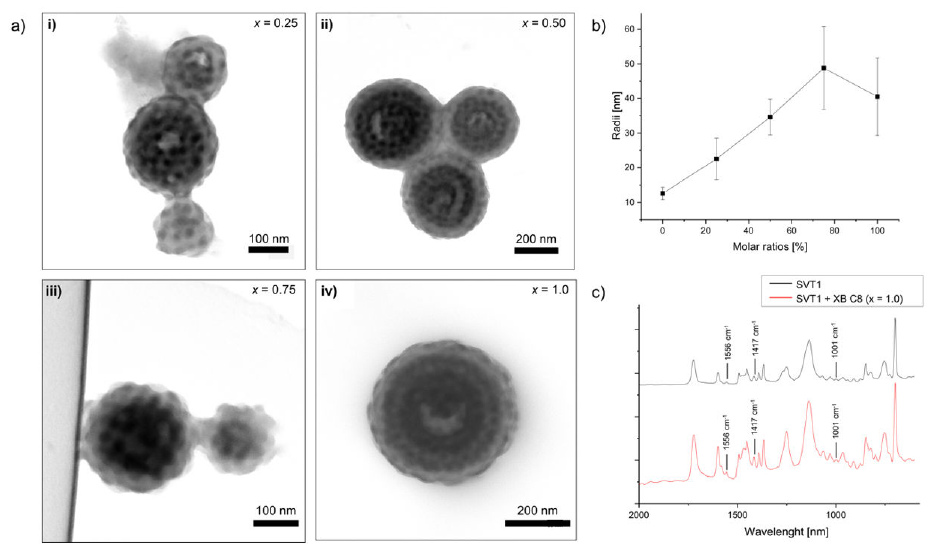
Figure 2. Microparticles made from SVT1/XB C8. ( a ) TEM of SVT1 with an increasing molar fraction of XB C8: (i) x = 0.25, (ii) x = 0.50, (iii) x = 0.75, (iv) x = 1.00. (Color code in TEM image: PS grey, P4VP dark grey due to iodine staining; scale bars are 100 nm). ( b ) Dependence of P4VP domain size on added XB C8. ( c ) IR spectra of SVT1 (black) and SVT1/XB C8 ( x = 1.00,